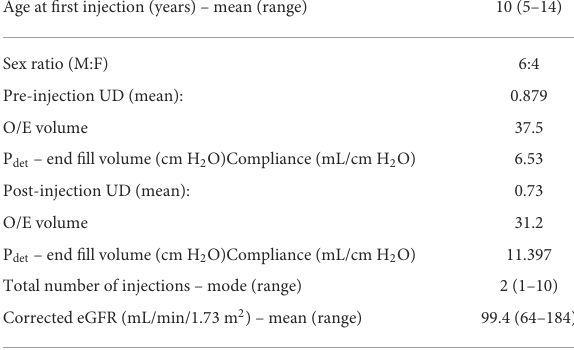
TABLE 3 Results from the subgroup (10/71) of patients who received botulinum toxin A injections. Age at first injection (years) – mean